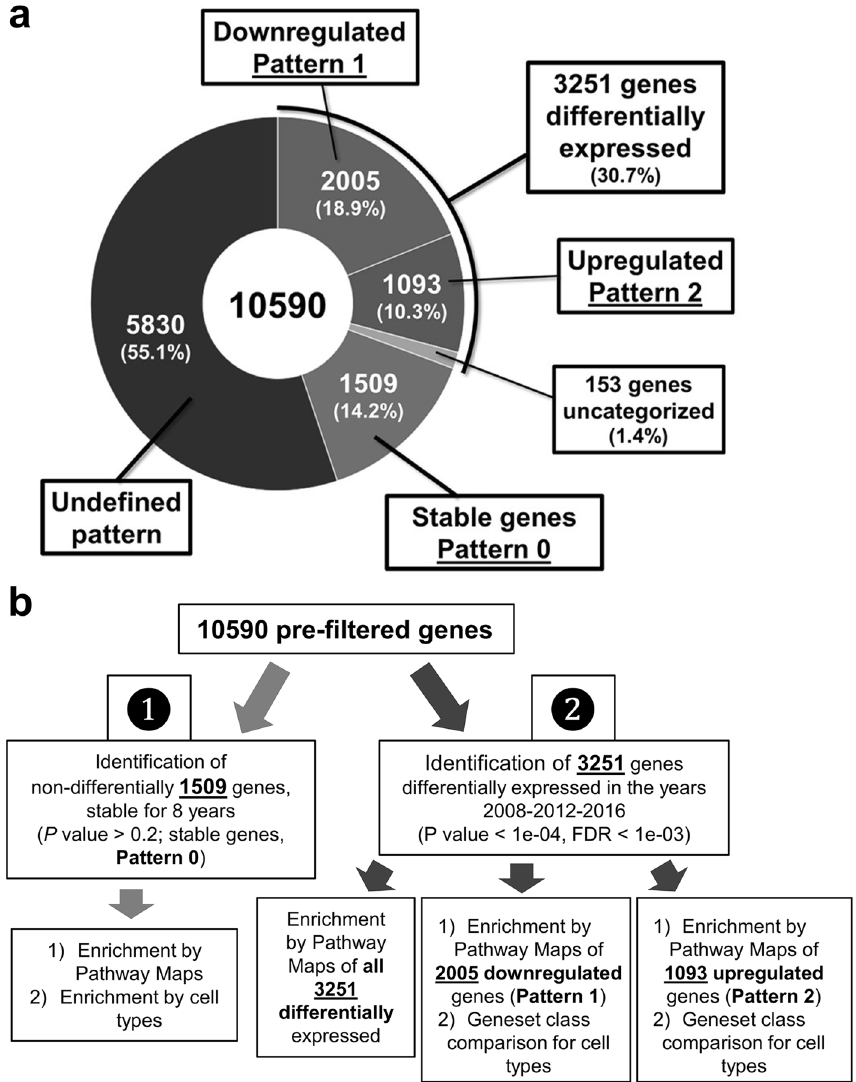
Figure 4. Percentage fraction of stable and altered genes within the 10,590 genes and relative flow analysis chart. ( a ) Pie chart indicating the percentage of stably expressed genes (Pattern 0), downregulated genes (Pattern 1), and upregulated genes (Pattern 2) within all 10,590 pre-filtered genes. ( b ) Analysis flow for enrichment and Geneset Class Comparison